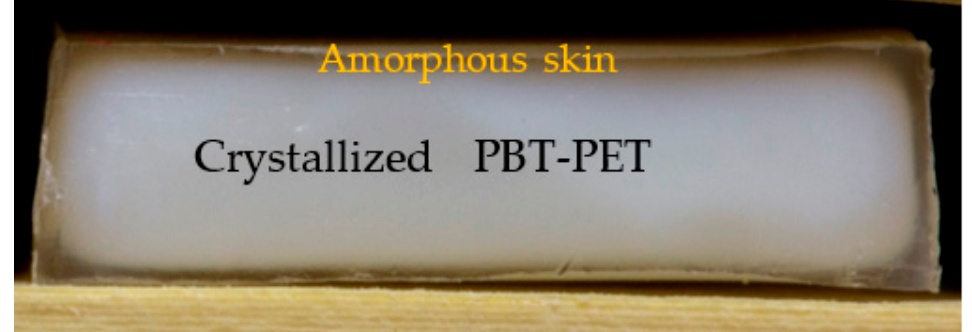
Figure 4 . Cross-section of the 60/40 PBT/PET bar shows a transparent jacket. The horizontal width of the bar is 12.7 mm. of the bar is 12.7